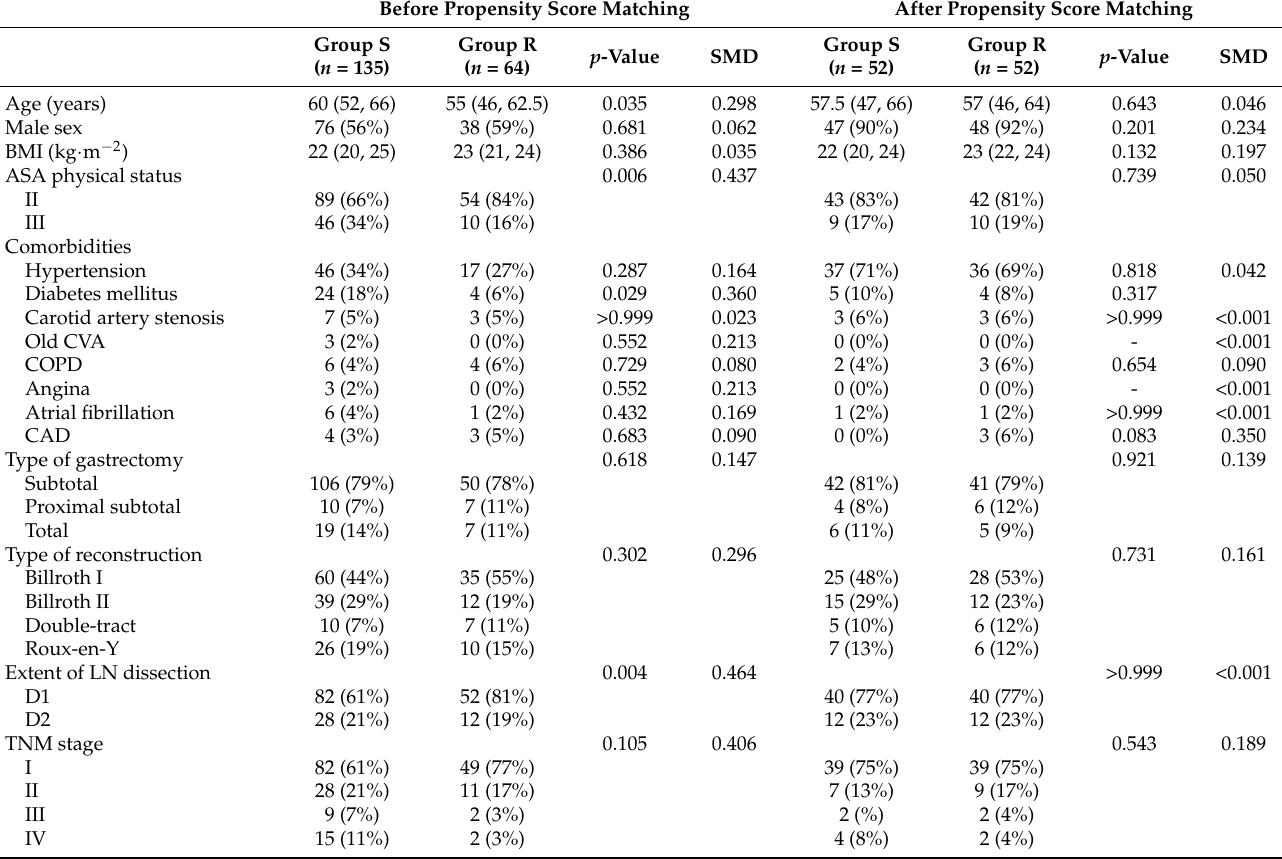
Table 1. Patient characteristics before and after propensity score